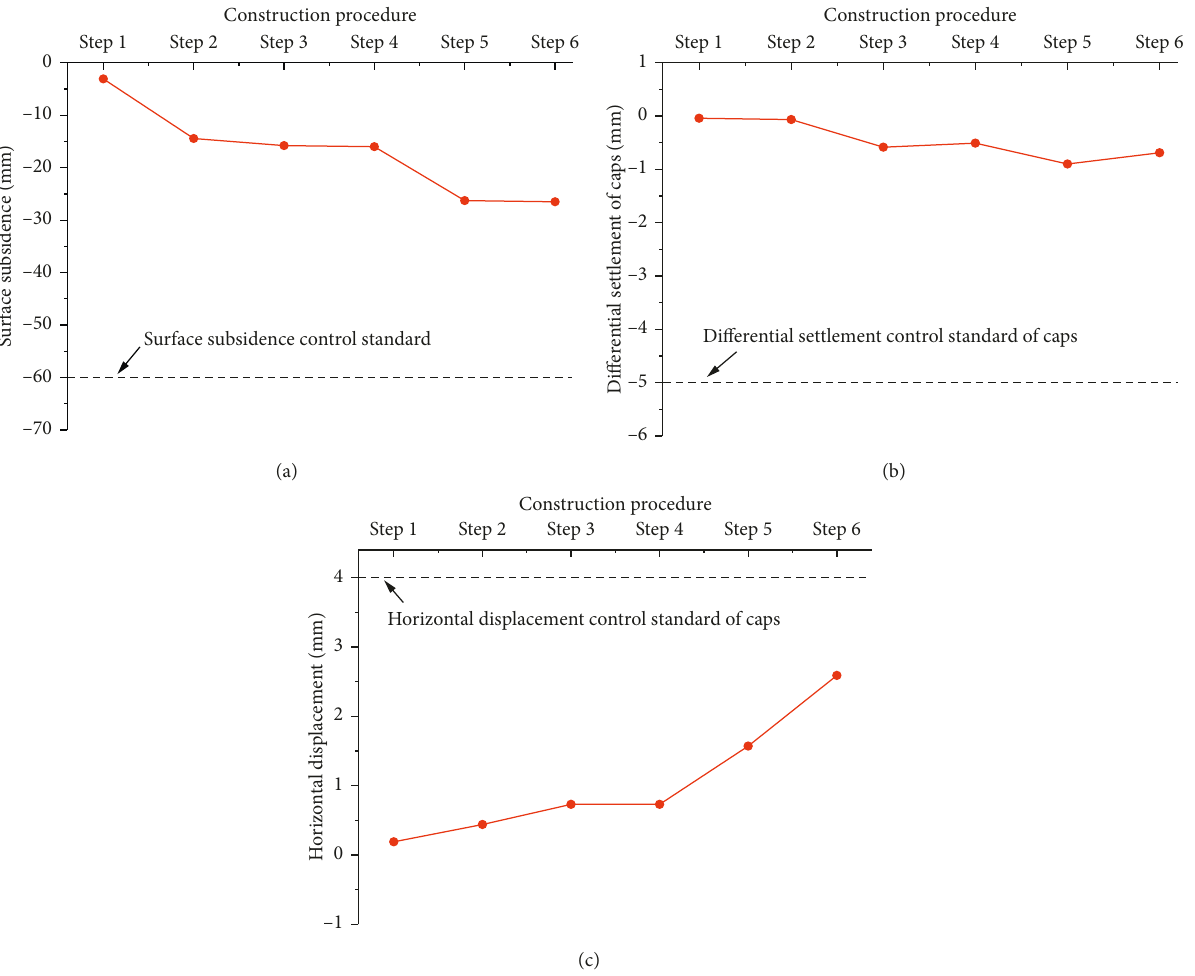
Figure 9: Calculation results. (a) Ground surface settlement. (b) Differential settlement of caps. (c) Horizontal displacement of